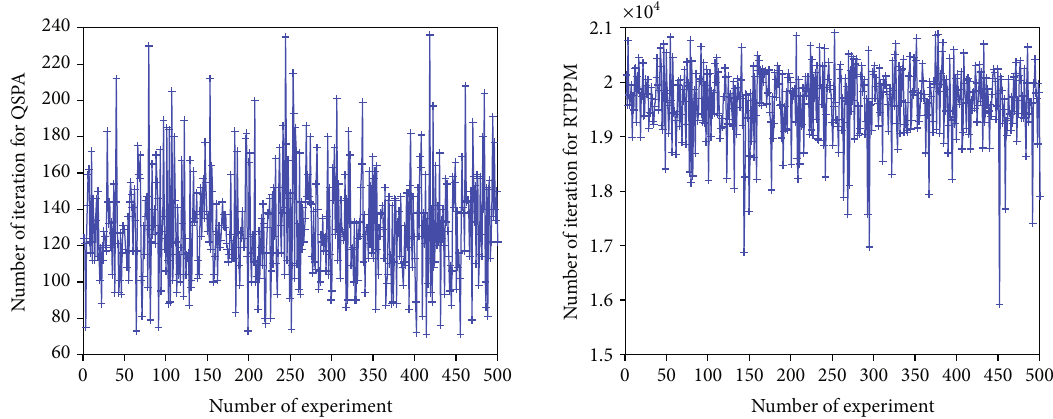
Figure 4: The iteration number of QSPA and